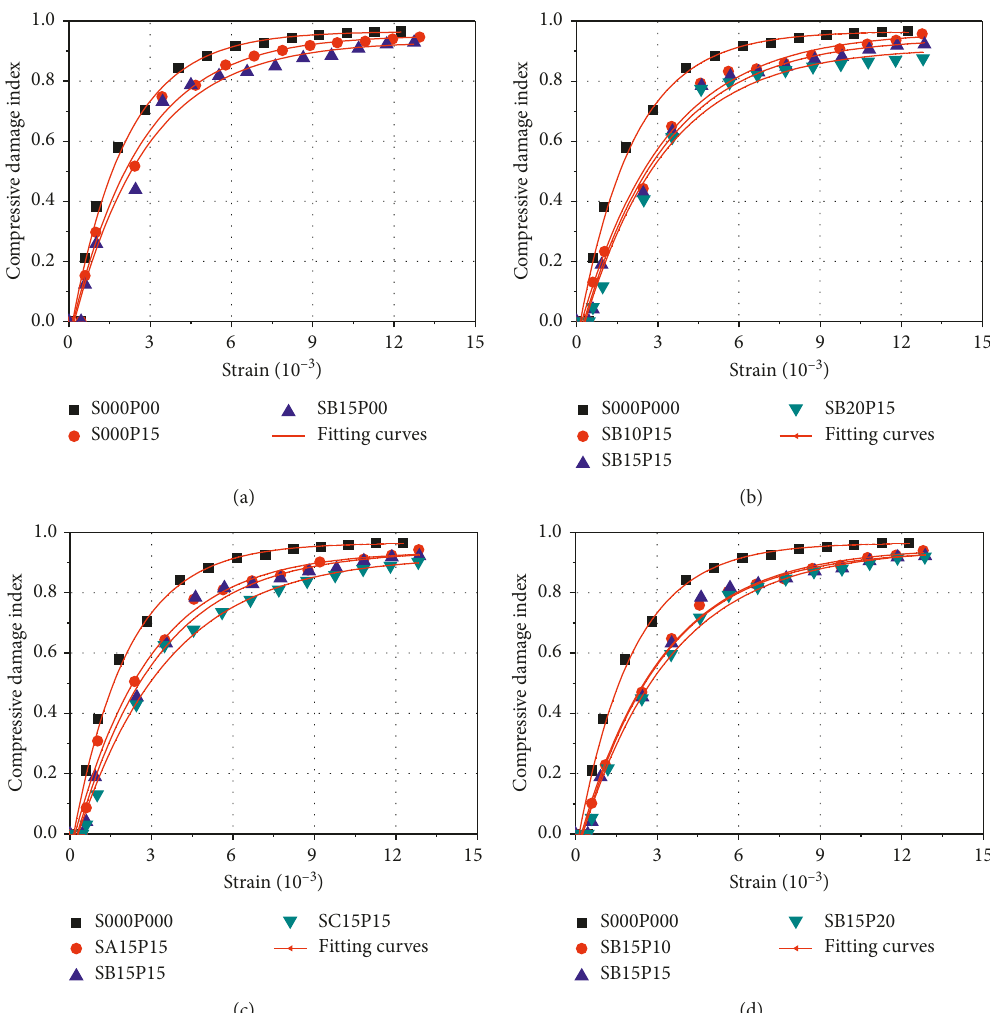
Figure 12: Damage evolution process of HFRC and fitting results under cyclic compression: (a) effect of fiber type; (b) effect of volume fraction of SF; (c) effect of aspect ratio of SF; (d) effect of volume fraction of